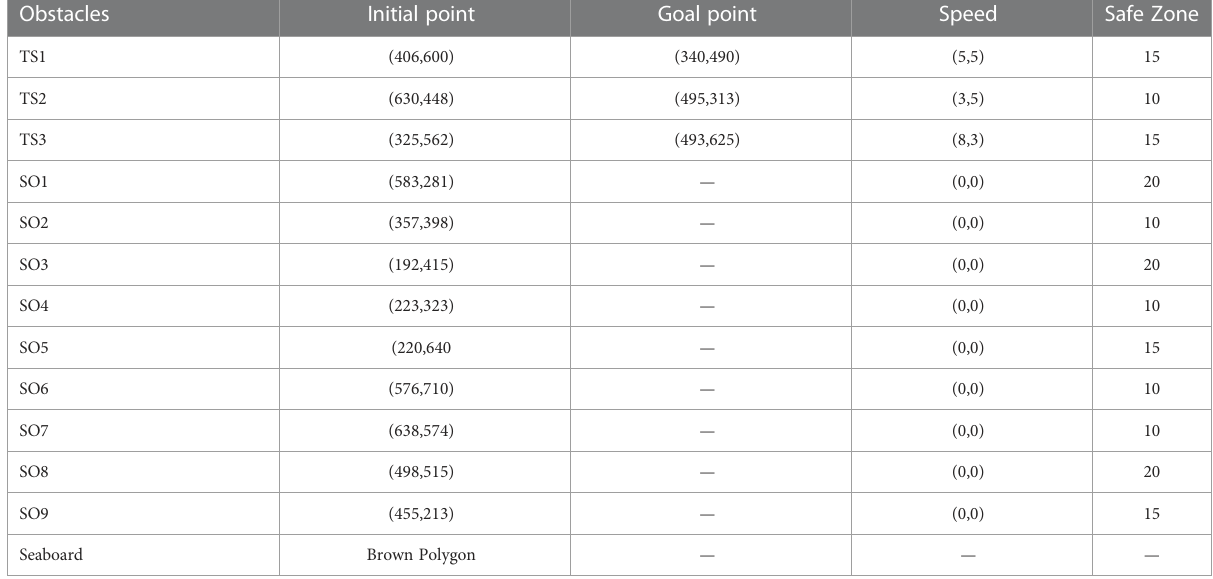
TABLE 3 The initial environment state settings parameters of the static-dynamic obstacles mixed environment. Obstacles Initial point